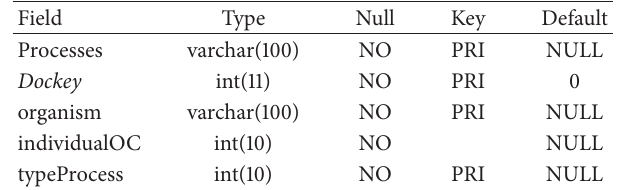
Table 2: Generic organism table description. Table 3: Generic